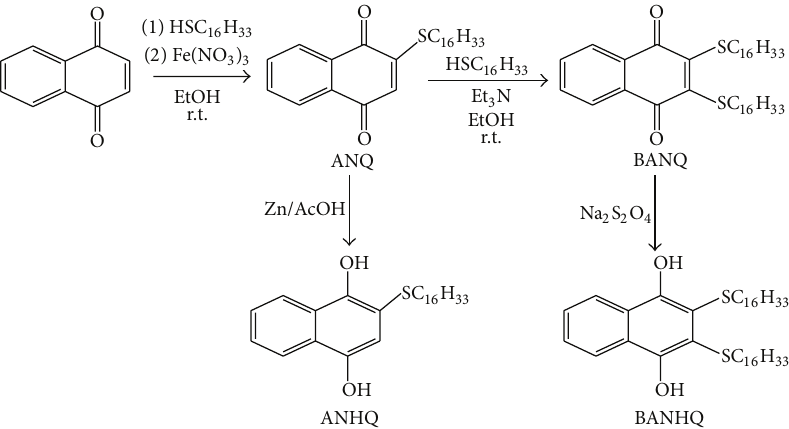
Scheme 1: Synthetic route for thionaphthoquinone